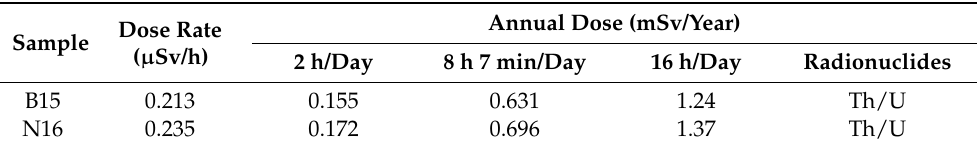
Table 4. Dose rates and annual effective dose from bracelet and necklace products, obtained using the IdentiFinder 2 portable